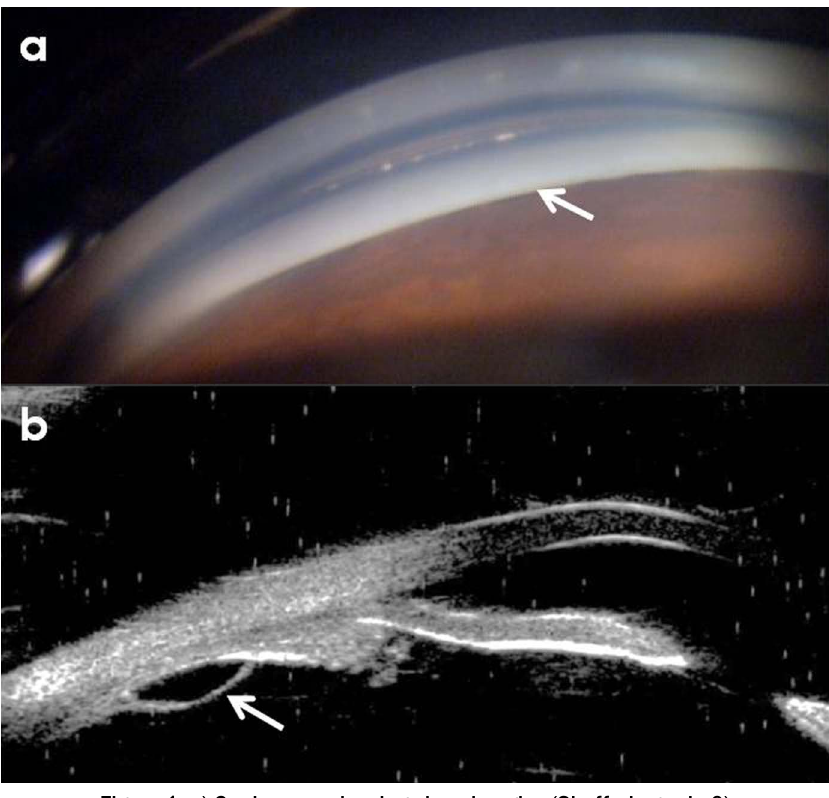
Figure 1: a) Gonioscopy showing closed angles (Shaffer’s grade 0) b) Ultrasound biomicroscopy picture showing ciliary body edema with adjoining cyst